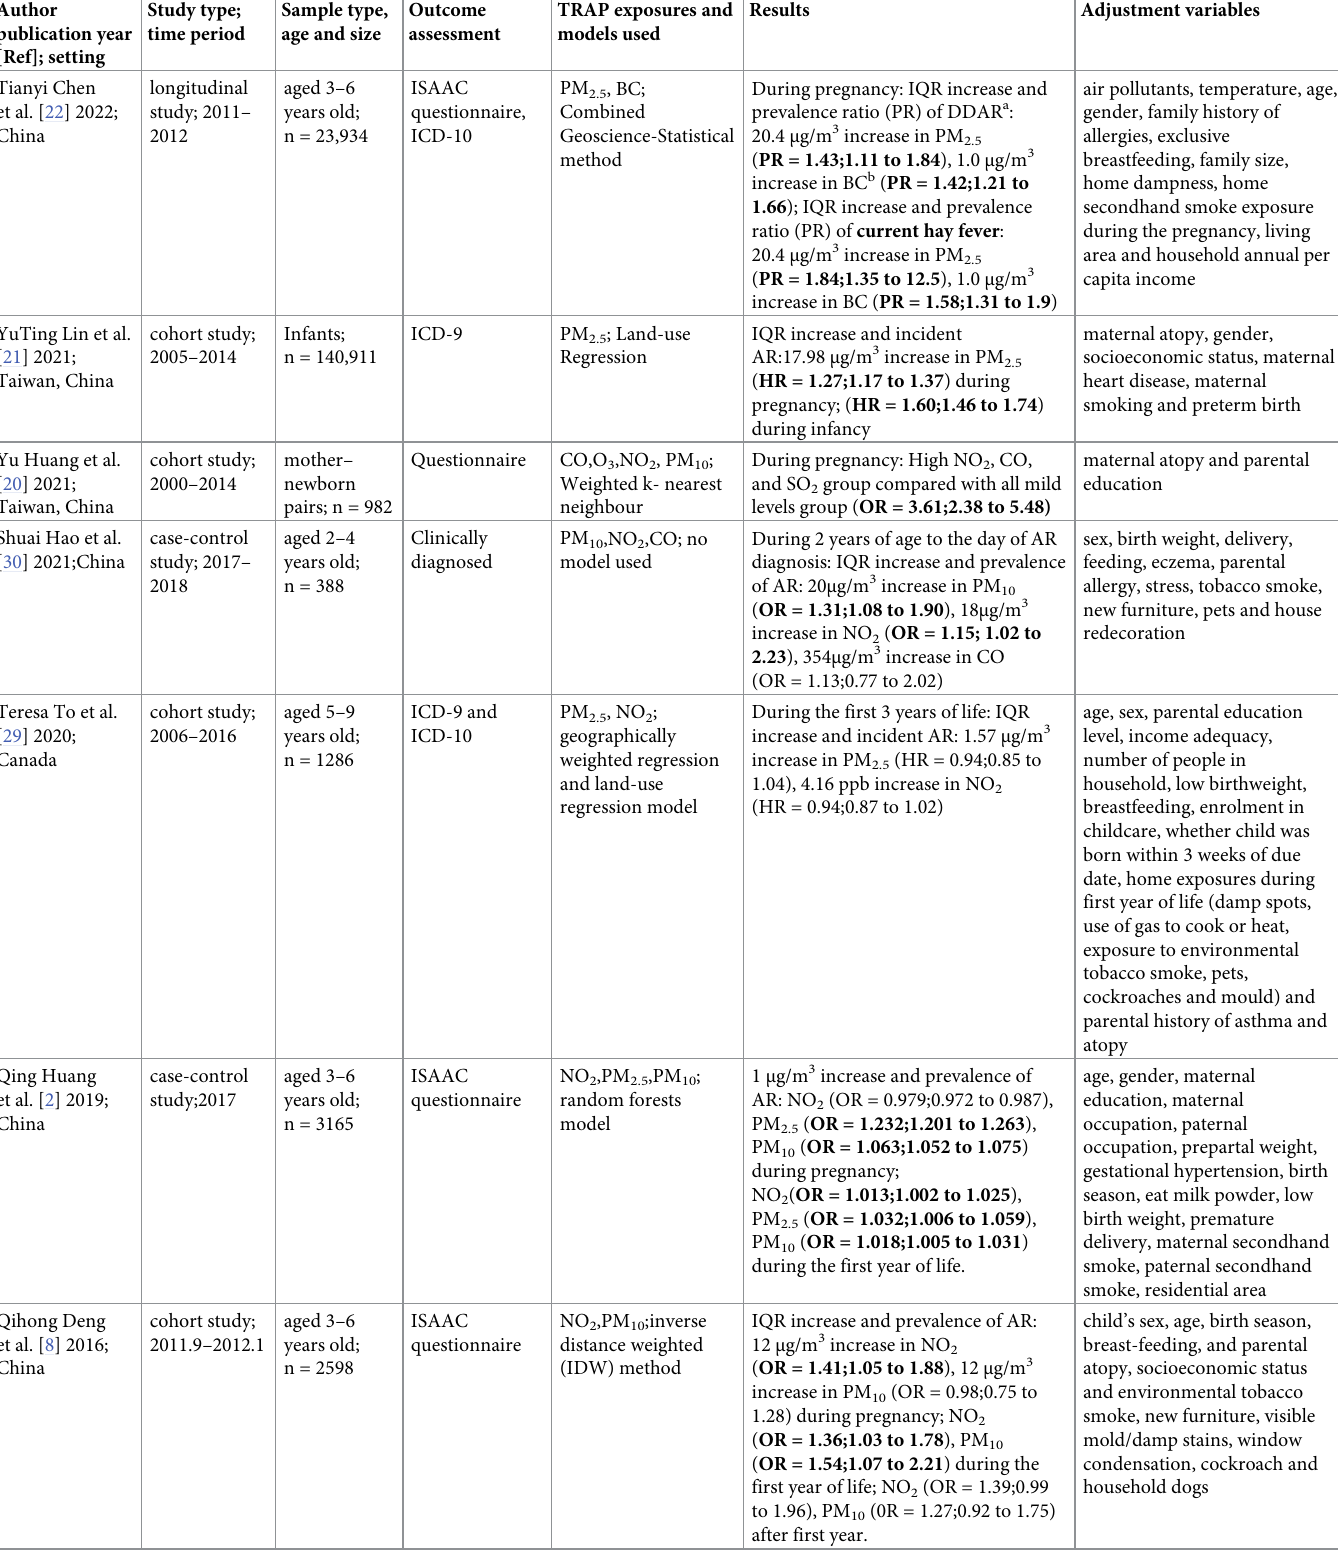
Table 1. Characteristics and main results of the studies on the association between traffic-related air pollution and allergic